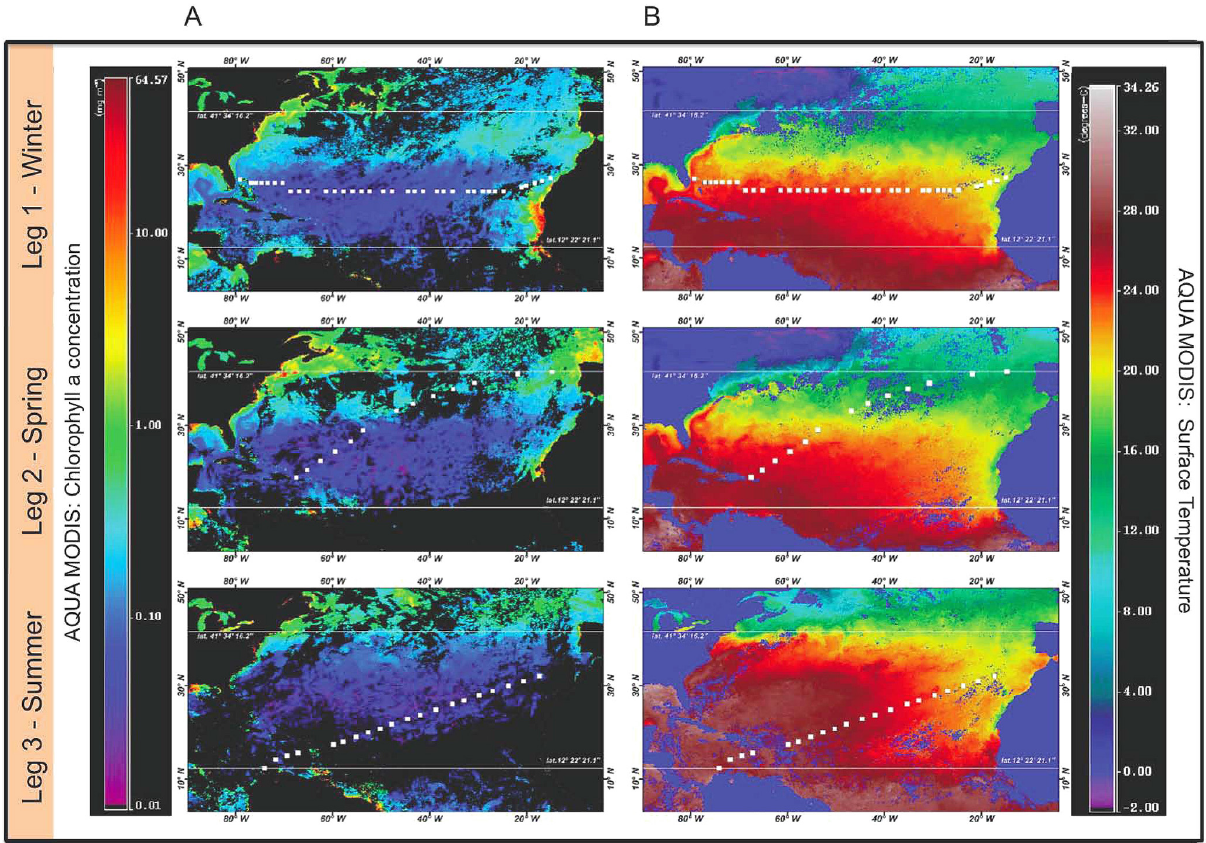
Figure 3. Satellite images showing 8-day-average chlorophyll a (a) and surface water temperature (b) from the date of the central station sampled in winter, spring and summer